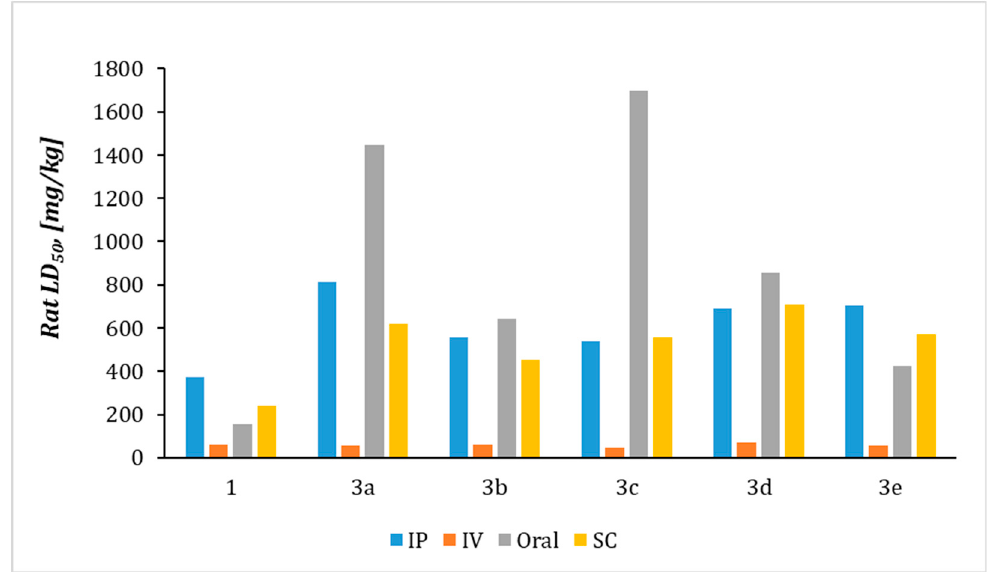
Figure 4. Acute rat toxicity predicted by GUSAR.